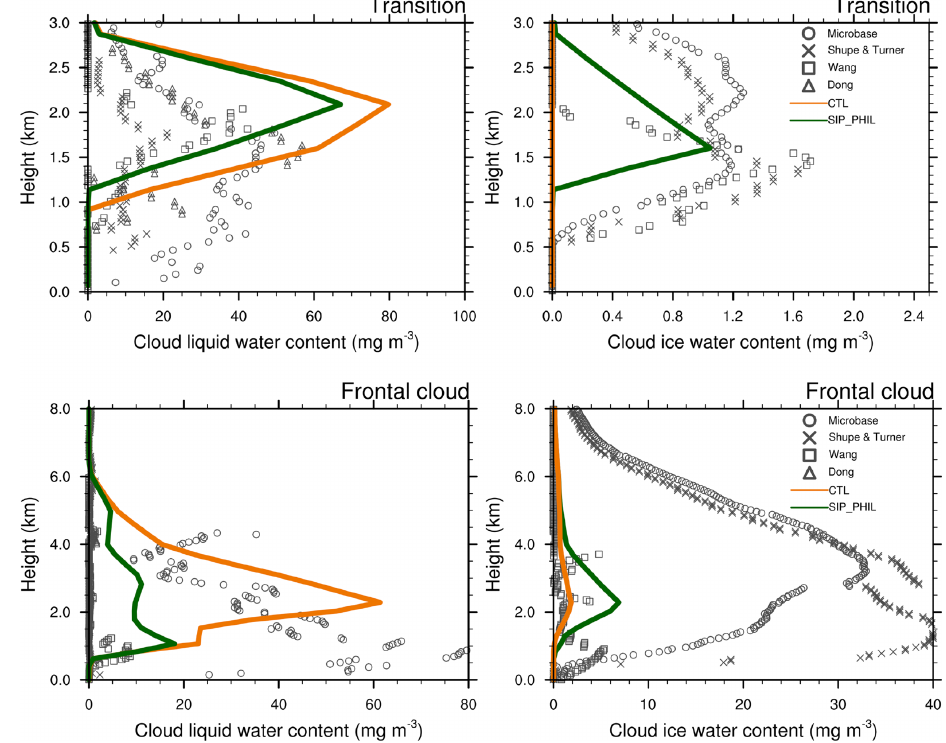
Figure 7. Vertical profiles of IWC and LWC during the transition and frontal cloud periods, from remote sensing retrievals shown by different markers, CTL experiment (solid orange line) and SIP_PHIL experiment (solid dark green